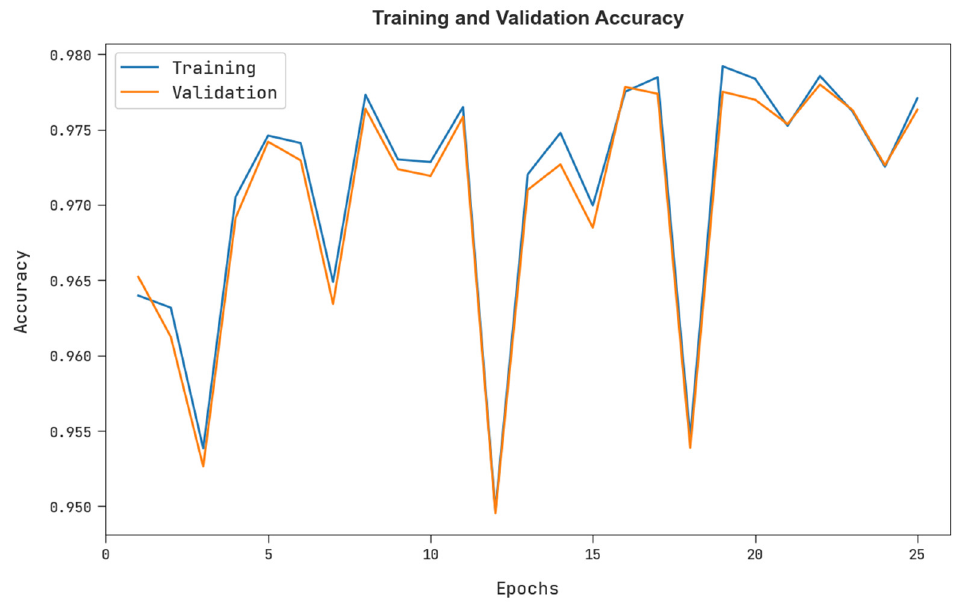
Figure 8. TRA and VLA analysis of FSHDBN-CID algorithm.